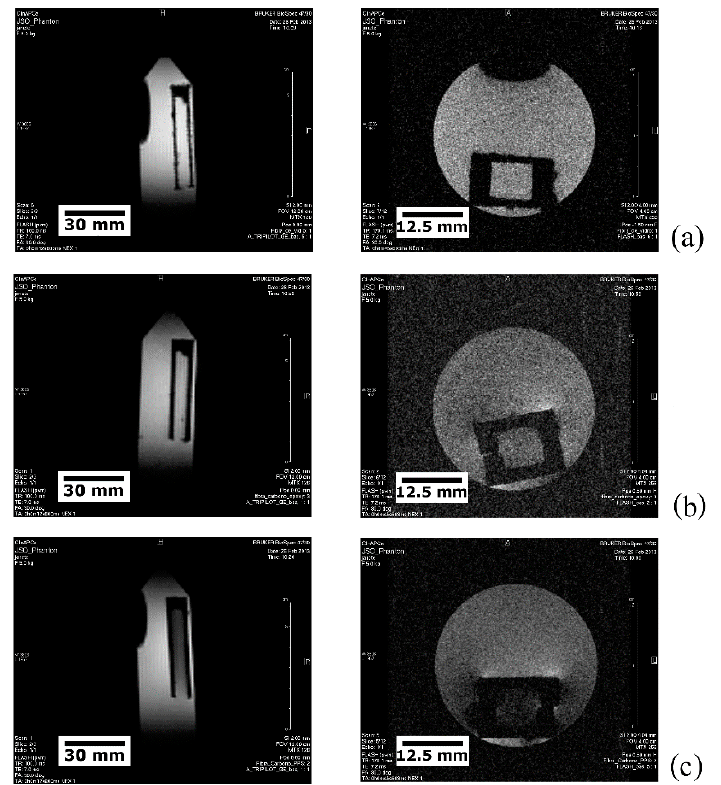
Figure 5. MRI tomographic views of: ( a ) the EPX-GF; ( b ) the EPX-CF; and ( c ) the PPS-CF vessels immersed in WSS.